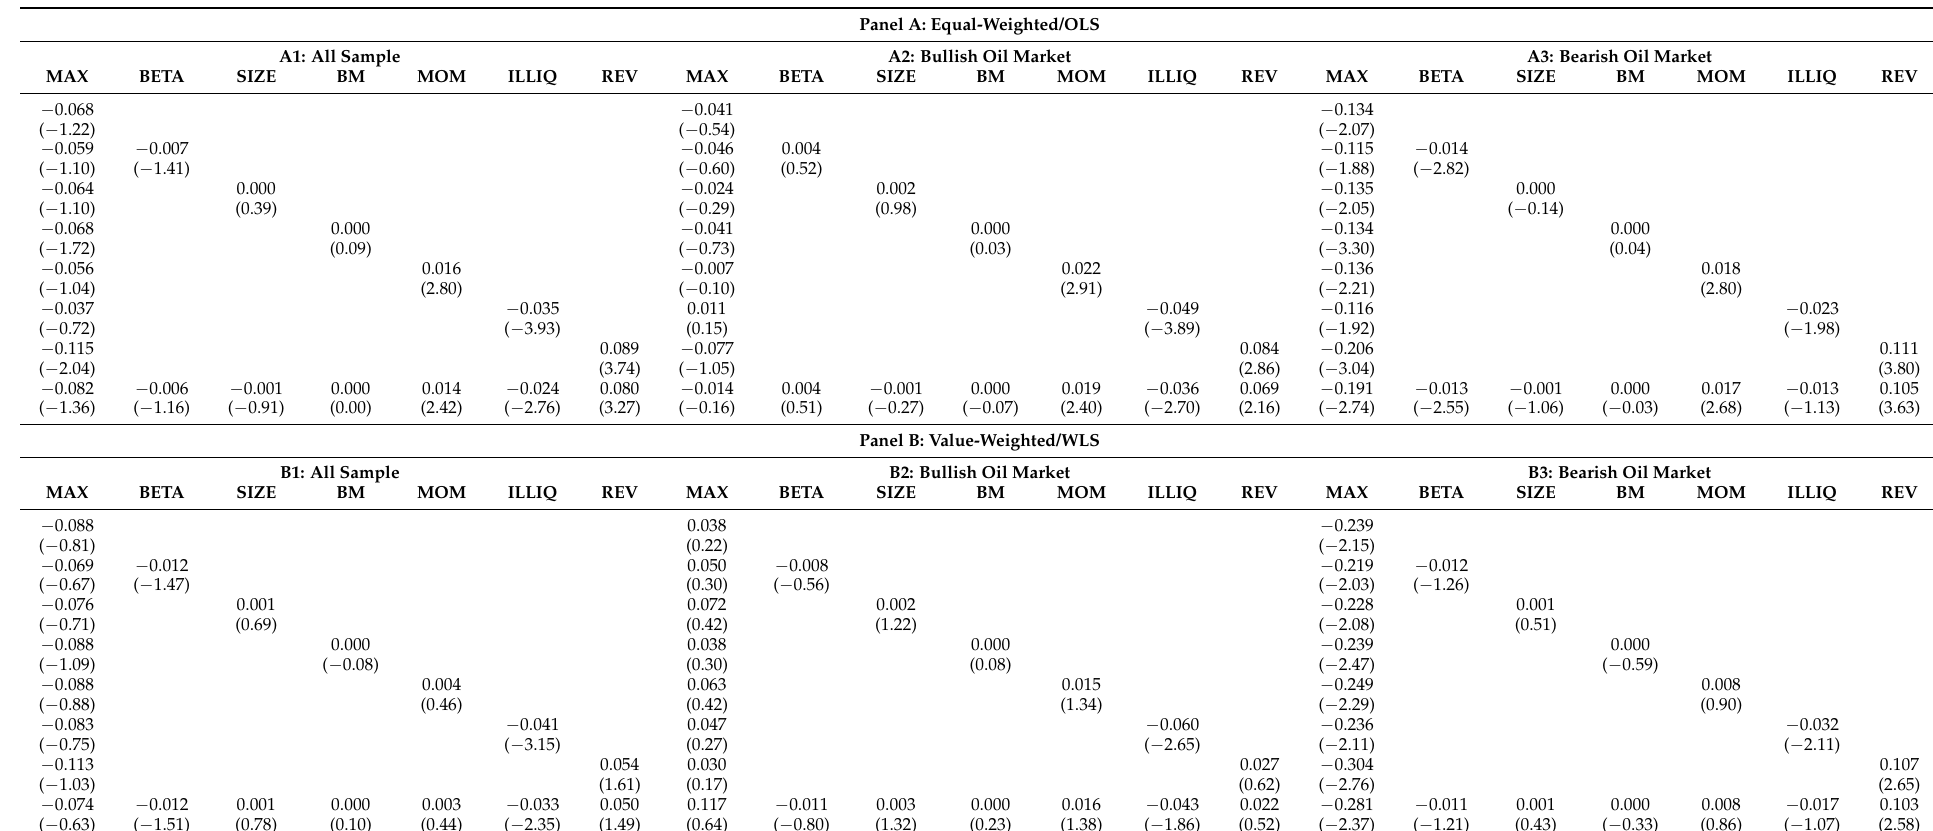
Table 5. This table reports the beta coefficients, with the associated Newey and West (1994) adjusted t-statistics in parentheses of firm-level OSL and WLS regression results. Panel A (Panel B) reports OLS (WLS) coefficient estimates of univariate, bivariate and full-specification multiple regressions, first for the whole sample, second for time periods when the oil market is bullish at the time of investment decision, and third for time periods when the oil market is bearish at the time of investment decision. The data are from January 1998 to December